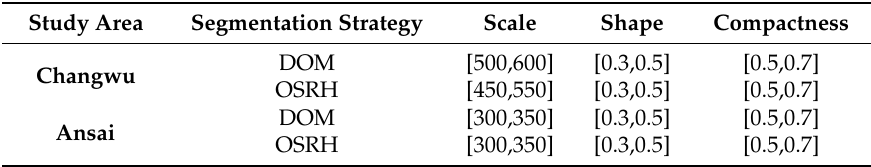
Table 1. The selection range of parameter for